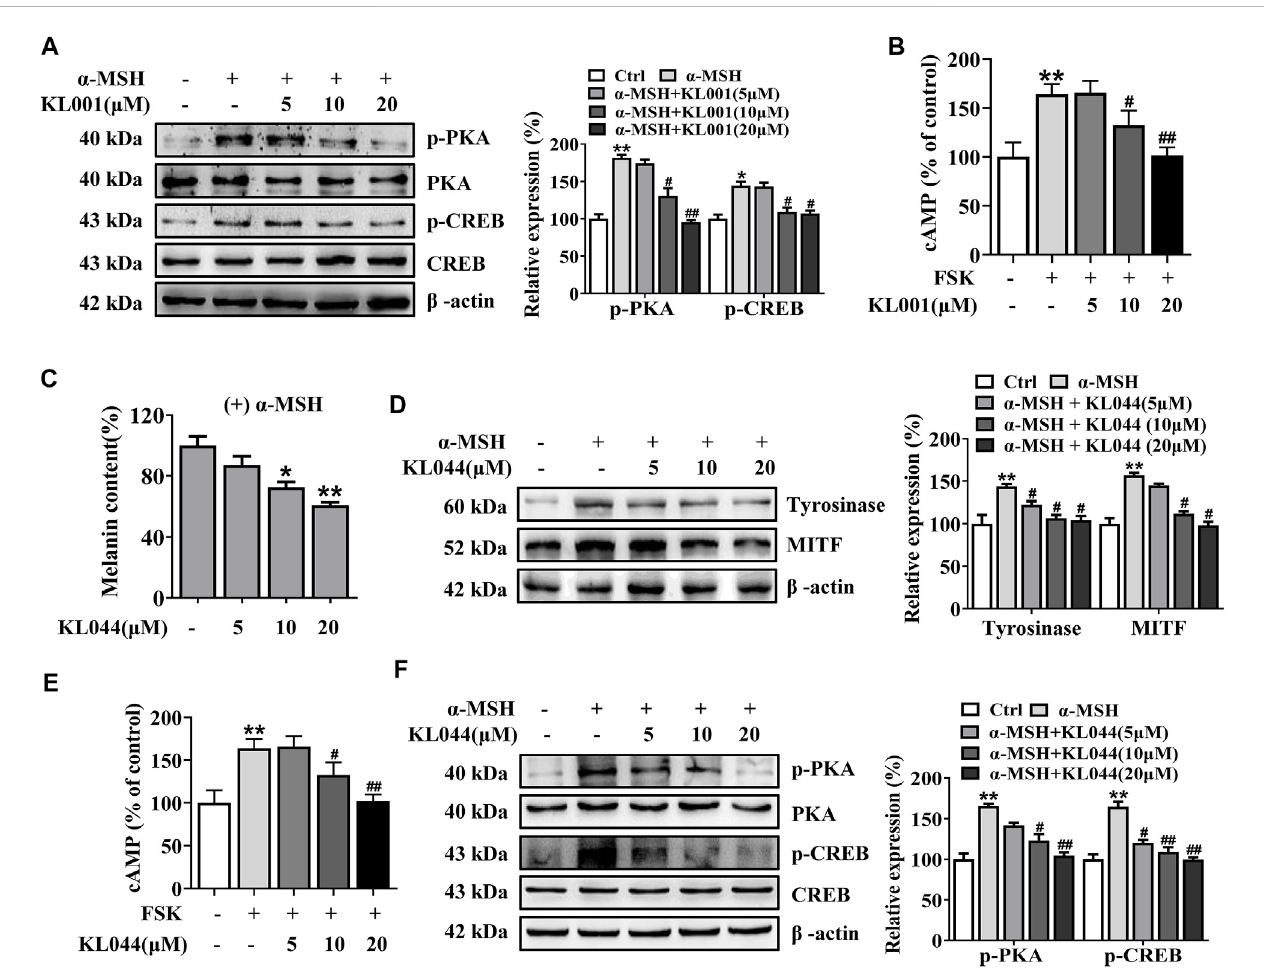
FIGURE 5 KL001 and KL044 suppressed cAMP/PKA/CREB signaling pathway in B16F10 cells. (A) Phosphorylation of PKA and CREB, (B) Cellular cAMP levels were detected. B16F10 cells were pretreated with KL001 for 2 h and stimulated with α -MSH for 20 min or FSK for 10 min in the presence of KL001. (C – F) Melanogenesis ef fi cacyand relatedsignaling pathway ofKL044weredetected.Dataareexpressedasthemean±SD( n =3).* p < 0.05,** p < 0.01versusnon- treated cells. # p < 0.05, ## p < 0.01 versus α -MSH- or FSK-treated